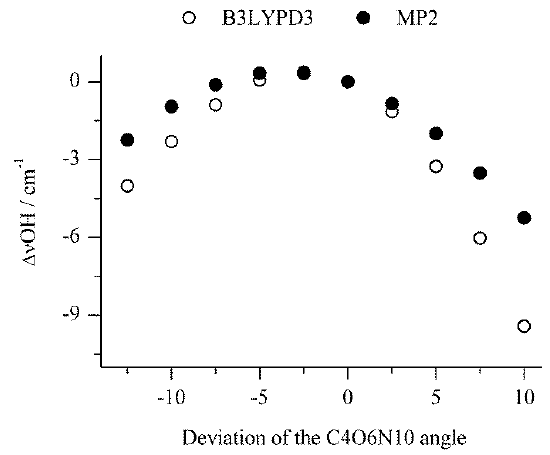
Figure 4. Plot showing changes of the ν OH value calculated for each point of the relaxed potential energy scan for the bending movement of the N 2 molecule in SSC1 complex calculated at the B3LYPD3 and MP2 levels with 6-311 ++ G(2d,2p) basis set versus deviation of the C4O6N10 angle. The zero value of this angle corresponds to the global minimum value.